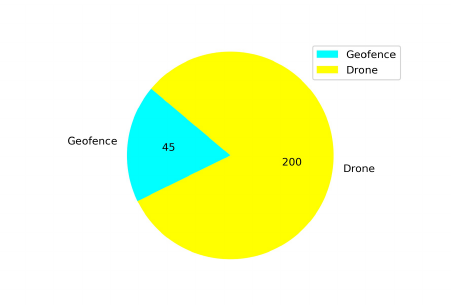
Figure 31. Crash report chart for Case 1.4 by Transfer Learning.